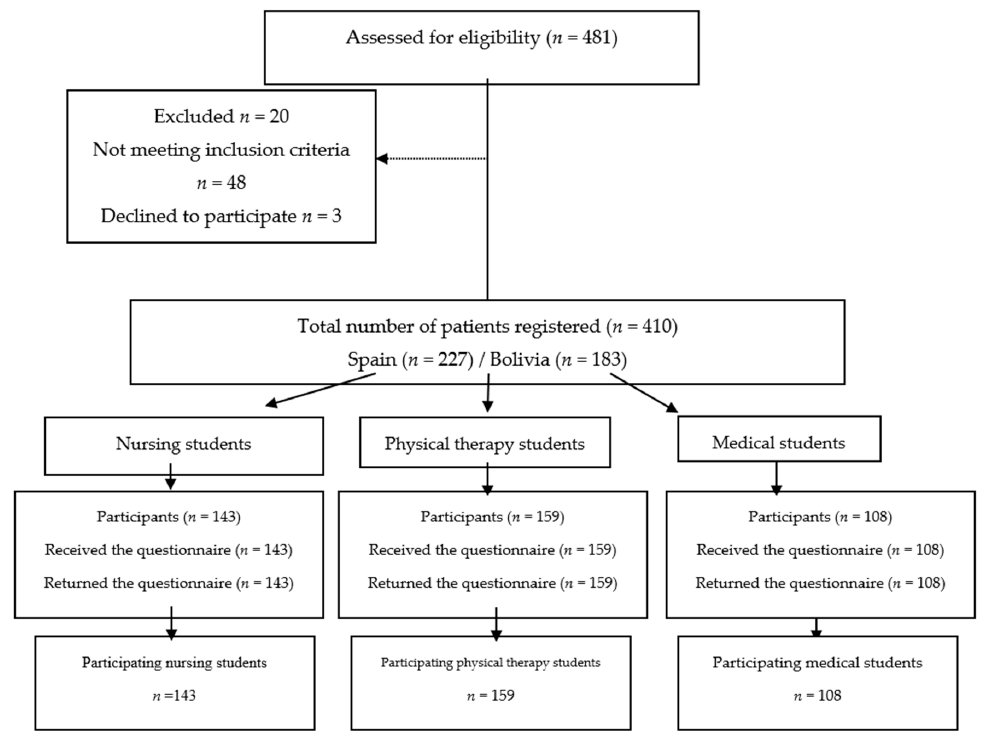
Figure 1. Study design flowchart.